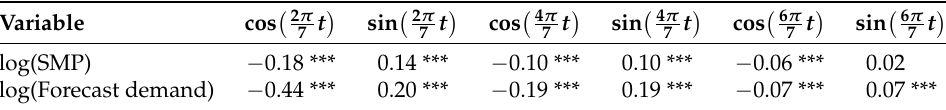
Table 6. Correlation of the log of the SMP and the log of the forecast demand with periodic functions.